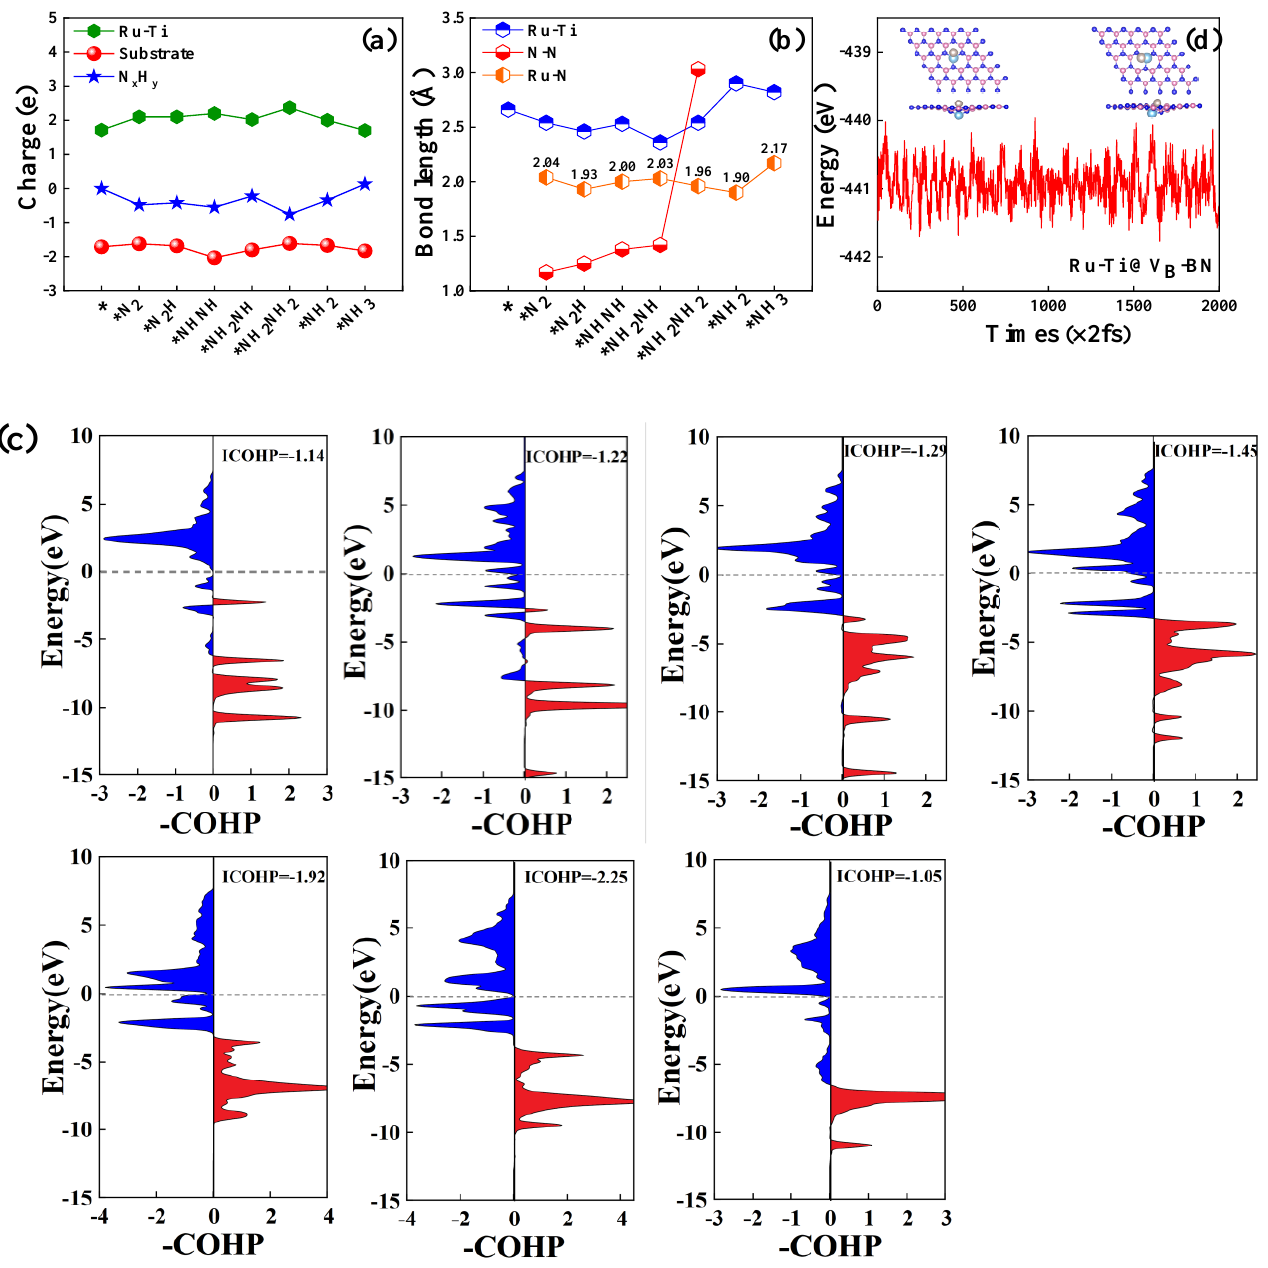
Figure 6. ( a ) Charge variations of defective BN monolayer, dopant TM pairs and the adsorbed N x H y species along the enzymatic mechanism. ( b ) Bond-length evolutions of N-N, Ru-N and Ru-Ti dimer. ( c ) Projected crystal orbital Hamilton populations (pCOHPs) between the TM and N atom in *N 2 , *NNH, *NHNH, *NHNH 2 , *NH 2 NH 2 , *NH 2 and *NH 3 on Ru-Ti@V B -BN. ( d ) AIMD simulation for Ru-Ti@VB-BN under 400 K.